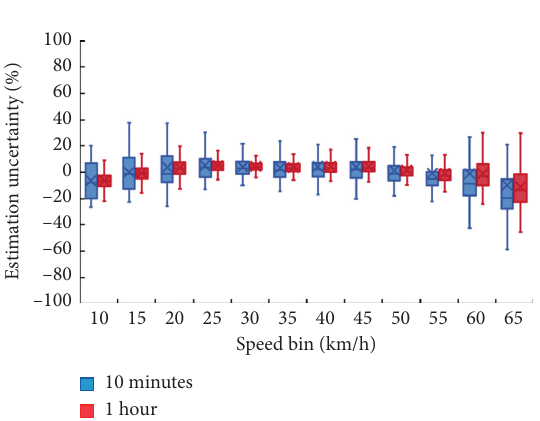
Figure 4: Distribution of the estimation uncertainty of different aggregation intervals.